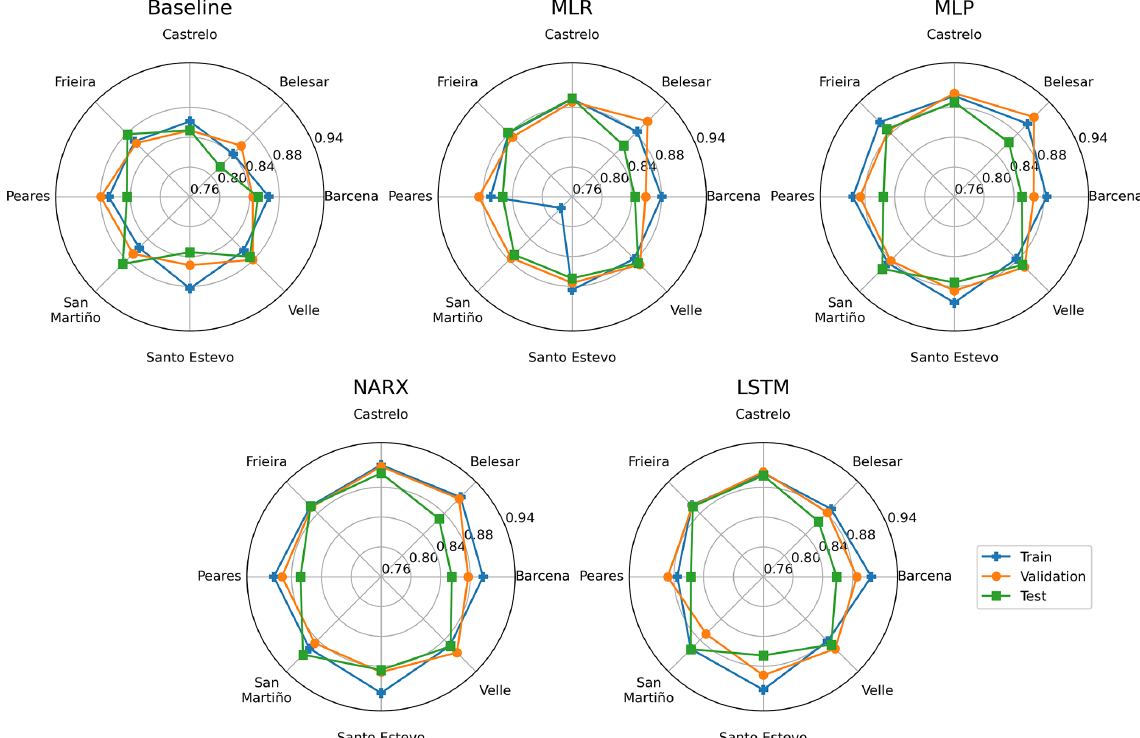
Figure 7. The NSE values for each dam obtained with five methodologies for train (blue line), validation (orange line) and test (green line).